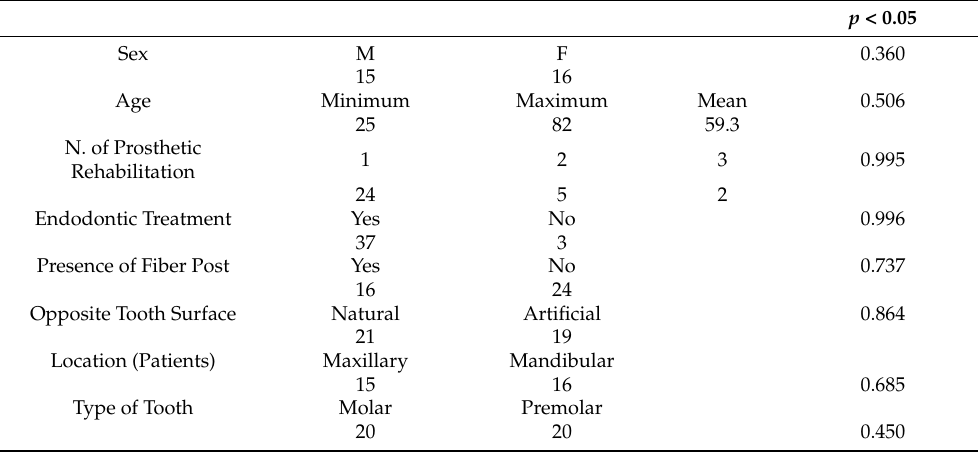
Table 4. Results of the univariate logistic regression between failures and different variables (statistical significance for p < 0.05).